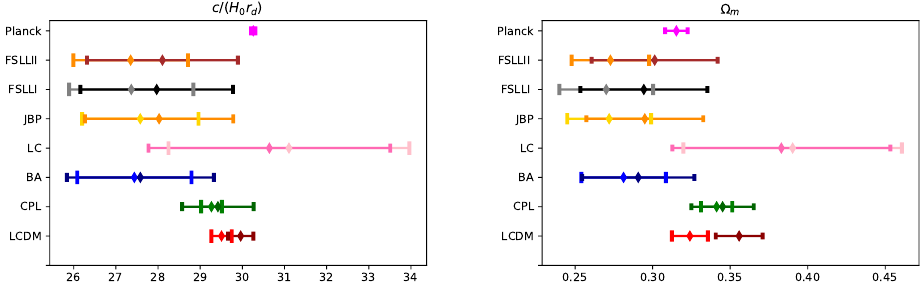
Figure 2. The final values of the c / ( H 0 r d ) from different DE models, compared to the values from Planck for the BAO+CMB+SN+GRB dataset. The smaller, darker, errorbox are for BAO+CMB, the lighter, bigger errorbox–for